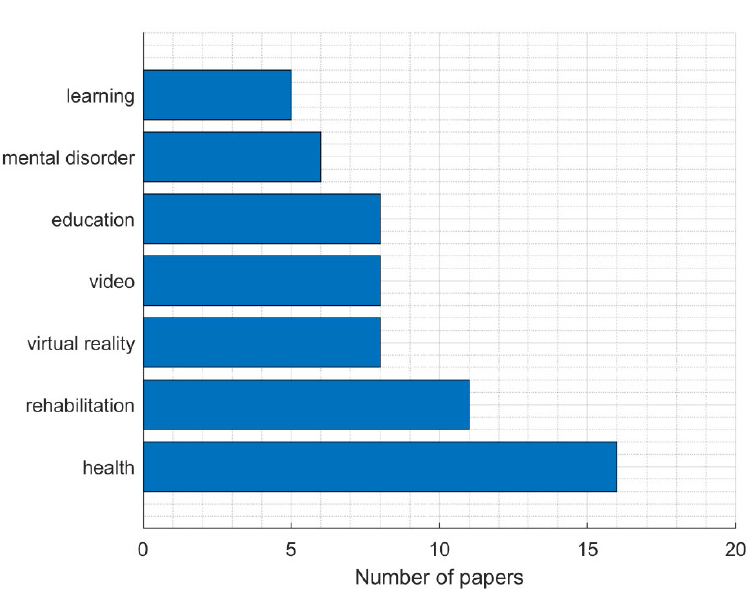
Figure 3. Most common terms used in keyword abstracts.